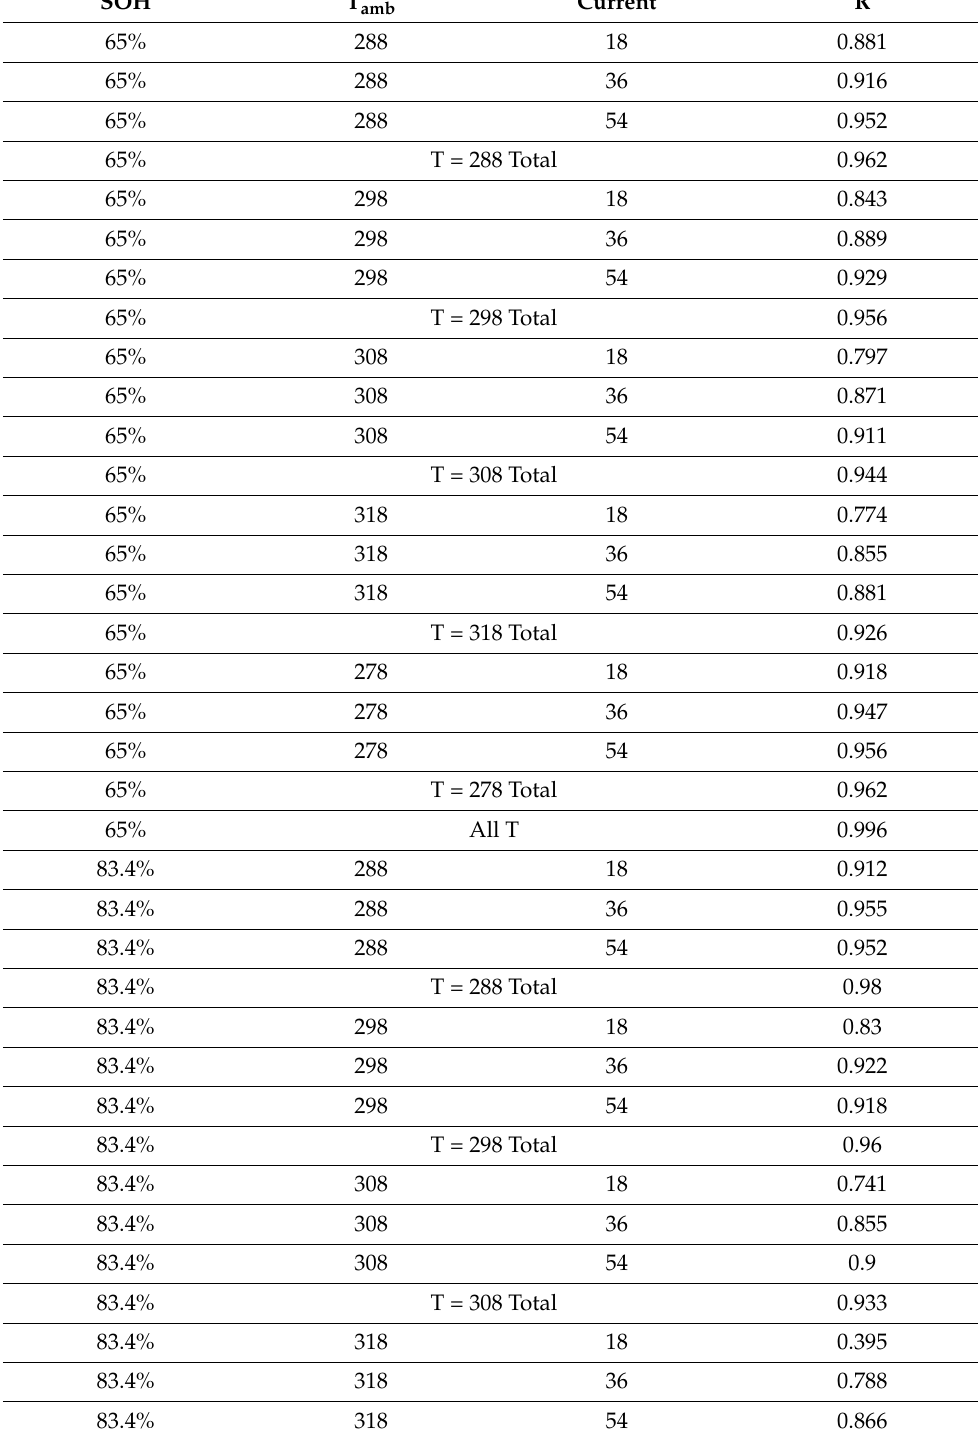
Table 8. Pearson Coefficients for 2D Model at Given SOHS, Ambient Temperatures and Currents. (Highest Accuracies